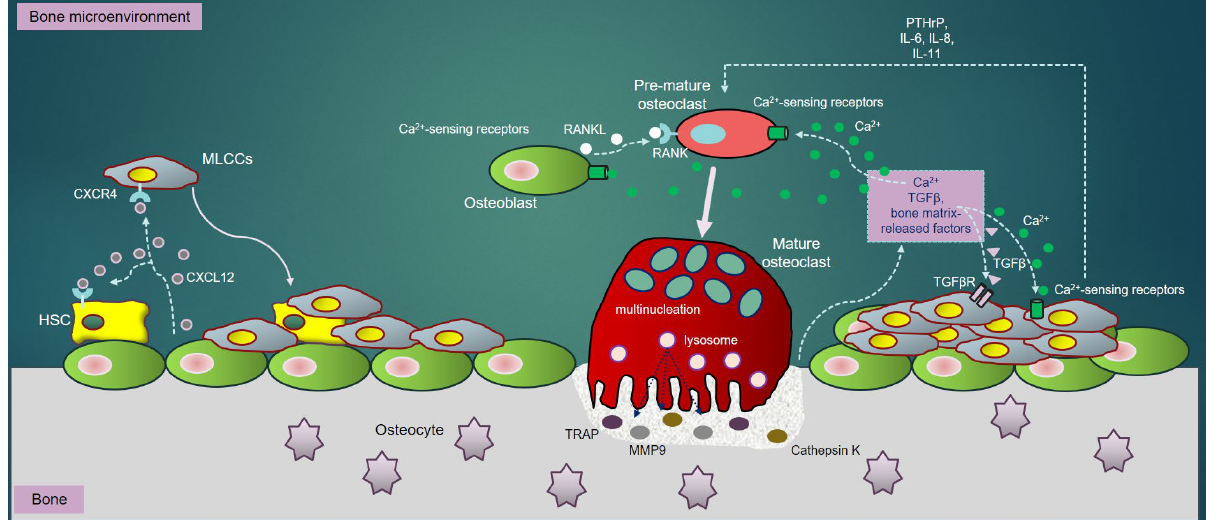
Figure 1. The MLCCs in bone: once in bone extracellular matrix (BEM), MLCCs encounters with the bone marrow stromal cells. The CXCR4/CXCL12 interaction enables MLCCs to attach to the osteogenic niches, strengthening MLCCs to survive, proliferate and metastasize. RANKL, secreted by OBs, directly binds to RANK receptor on PM of pre-OCs, triggering differentiation of pre-OCs into mature (multinucleated) OCs. Mature OCs secrete bone-resorbing elements including TRAP, CTSK and MMP9, all of which resorb bone to release Ca 2+ ions, TGFβ and other bone matrix-release factors into BEM. Ca 2+ ions released subsequently activate OC differentiation through NFATc-1 downstream signaling pathways. Besides, bone resorption-derived Ca 2+ ions interact with Ca 2+ - sensing receptors highly expressed in OBs, OCs and MLCCs, which further promotes survival, proliferation, differentiation and metastasis of MLCCs in bone. Moreover, the interaction of bone resorption-derived TGFβ to its receptor, TGFβR highly expressed in MLCCs, activates several important downstream signaling cascades such as MAPK, PI3K/Akt, and Rho-like GTPase, which synergistically enhance metastatic properties of MLCCs in bone. Additionally, the ILs (IL-6, IL-8 and IL-11) and PTHrP secreted by MLCCs also contribute towards augmentation of OC differentiation and bone